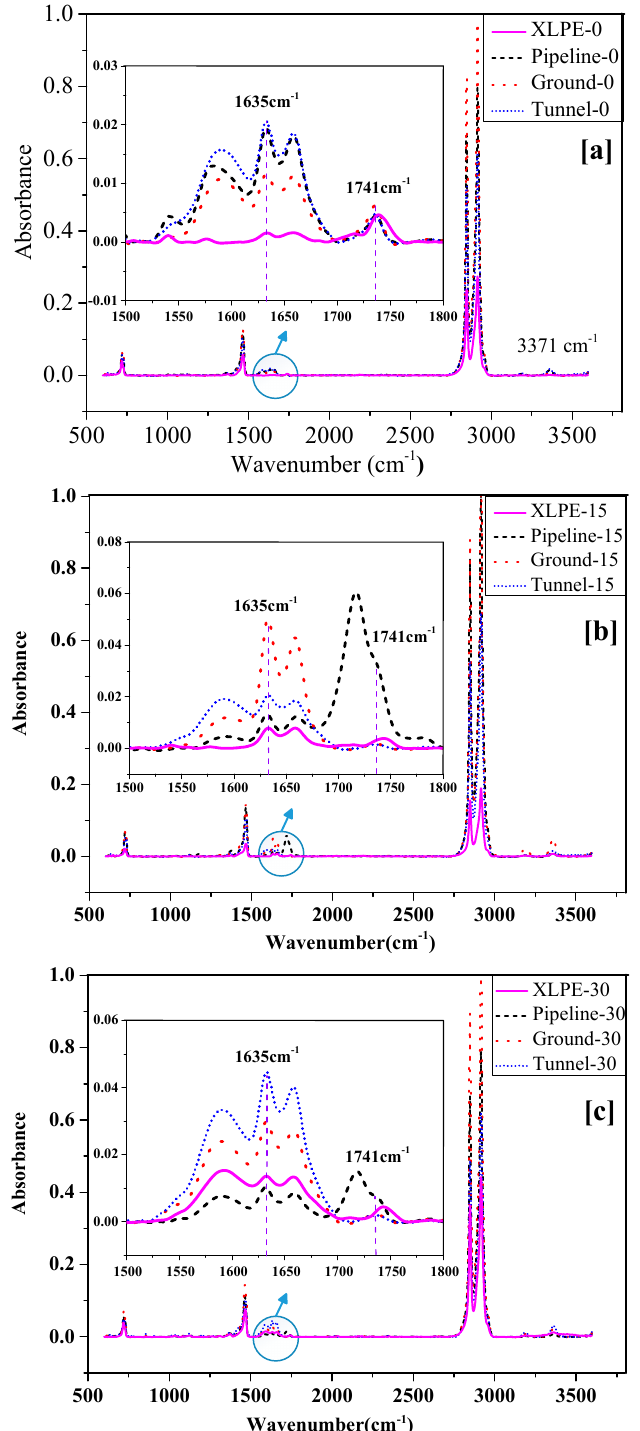
Figure 5. Fourier transform infrared spectroscopy (FTIR) spectra of the untreated specimens and the treated specimens under thermal aging of three di ff erent laying modes. ( a ) the spare cable; ( b ) the cable with service years of 15; ( c ) the cable with service years of